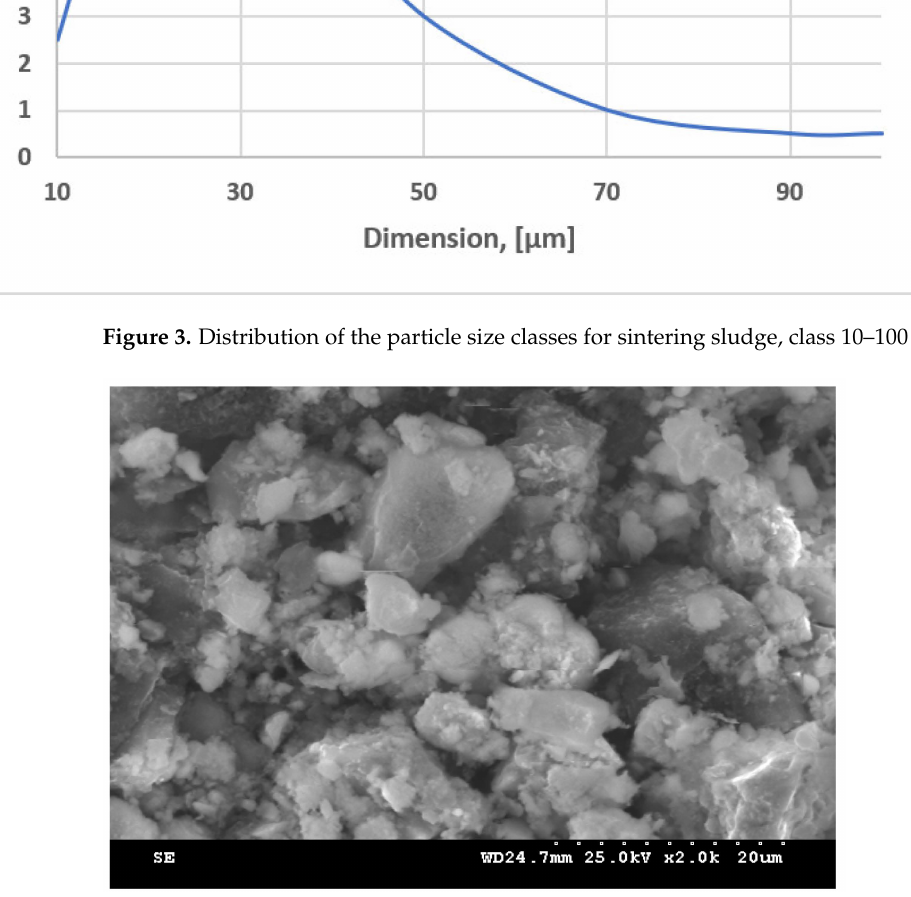
Figure 4. Image of sintering sludge, 4000 × .